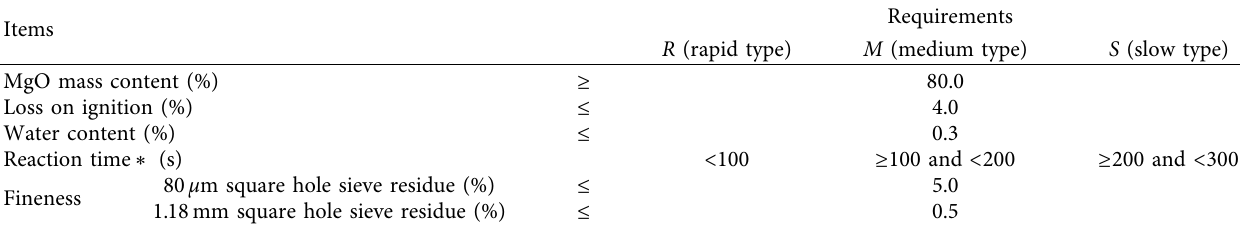
Table 1: Chemical and physical requirements for MgO expansive agent